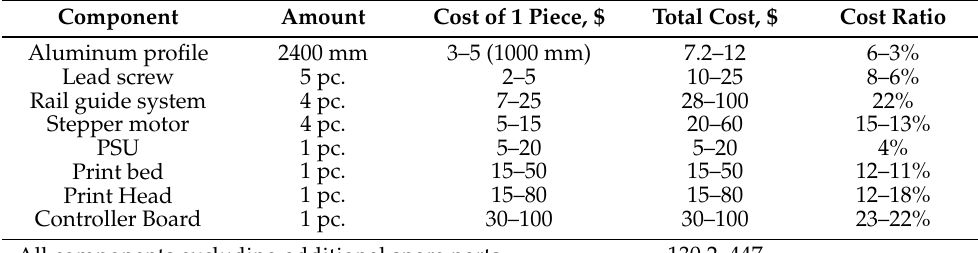
Table 4. The cost of a 3D printer in Figure